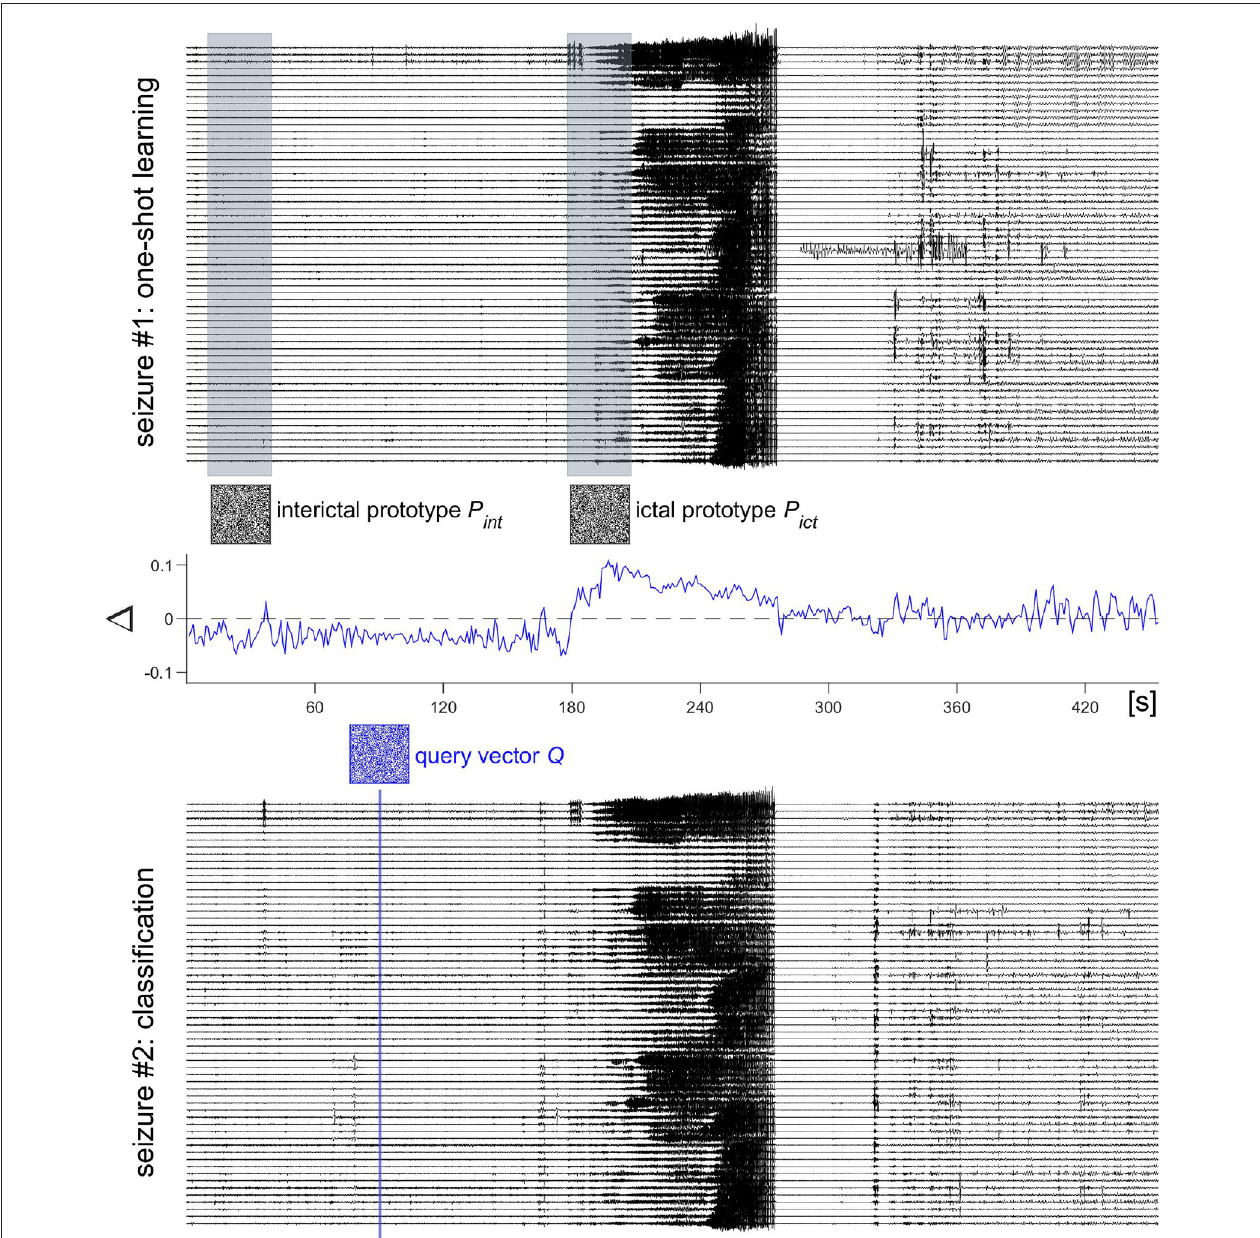
FIGURE 6 | HD computing for intracranial electroencephalogram (iEEG) seizure detection. Two iEEG seizure recordings from a patient with temporal lobe epilepsy are used. The patient was implanted with intracranial electrodes with a total of 60 contacts. From seizure # 1, two prototype hyperdimensional (HD) vectors are learnt, P int from an interictal time period and P ict from seizure onset. Both time periods have a length of 30 s and are displayed in gray. Learning consists of splitting the time periods into 30 non-overlapping moving windows of 1 s duration, computing a spatiotemporal composite representation and bundling these 30 representations into the corresponding prototypes. Seizure # 2 is then used for classification. From a short moving window, again of a duration of 1 s and displayed in blue, a query HD vector Q is computed and its normalized Hamming distances to the interictal and ictal prototype vectors are measured. The difference 1 = NHD ( Q , P int ) − NHD ( Q , P ict ) indicates if the current brain state is closer to the ictal ( 1 > 0) or the interictal ( 1 < 0) prototype. The amplitude of 1 and its time continuously spent > 0 allow defining thresholds and time periods for iEEG seizure detection with high sensitivity and specificity (50–52).